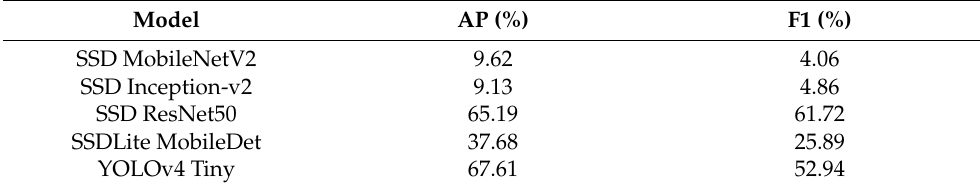
Table 9. AP and F1 absolute reduction from 0% to 95% confidence.